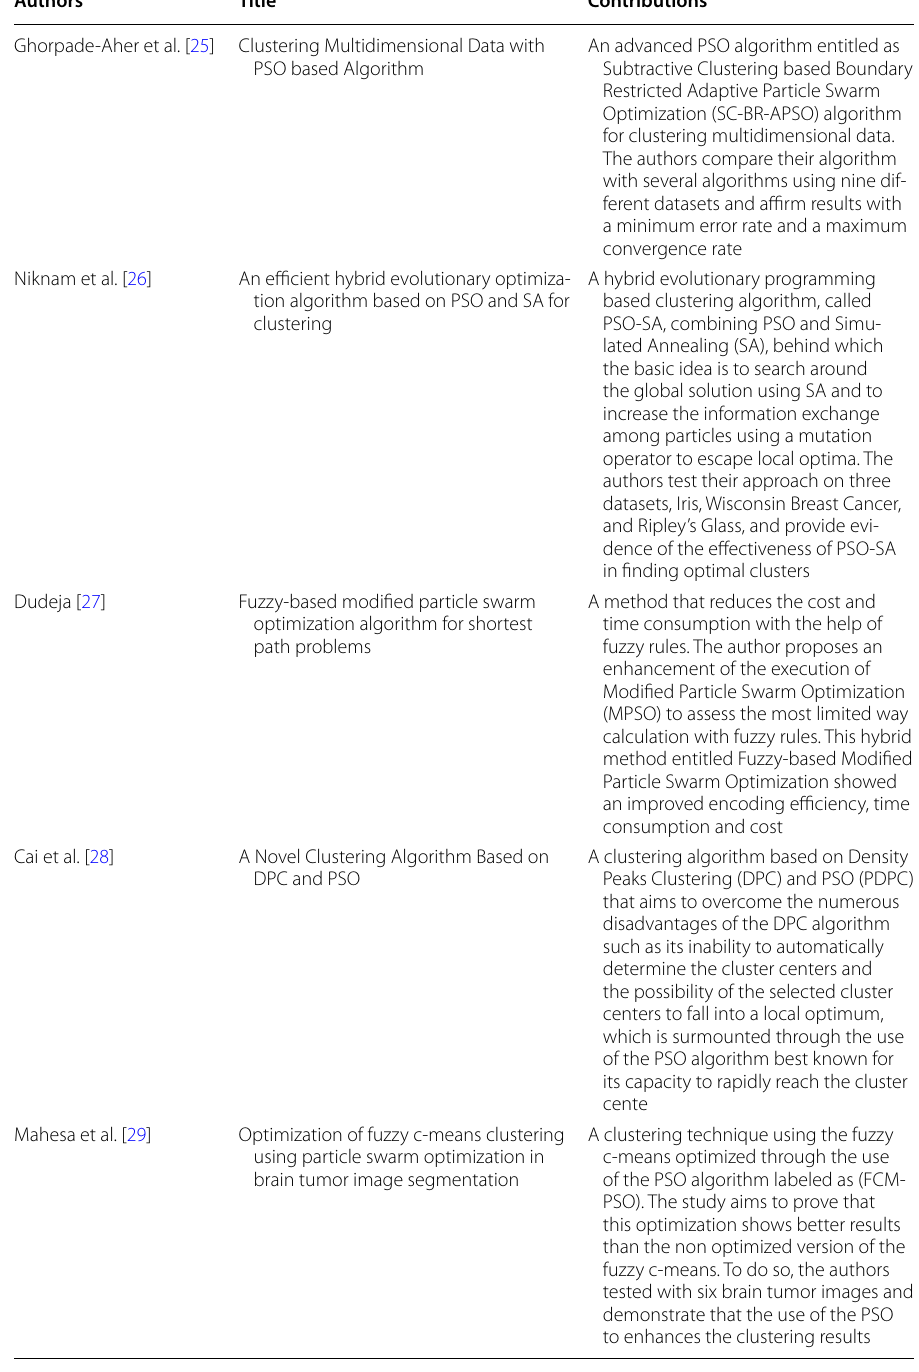
Table 3 PSO based clustering methods